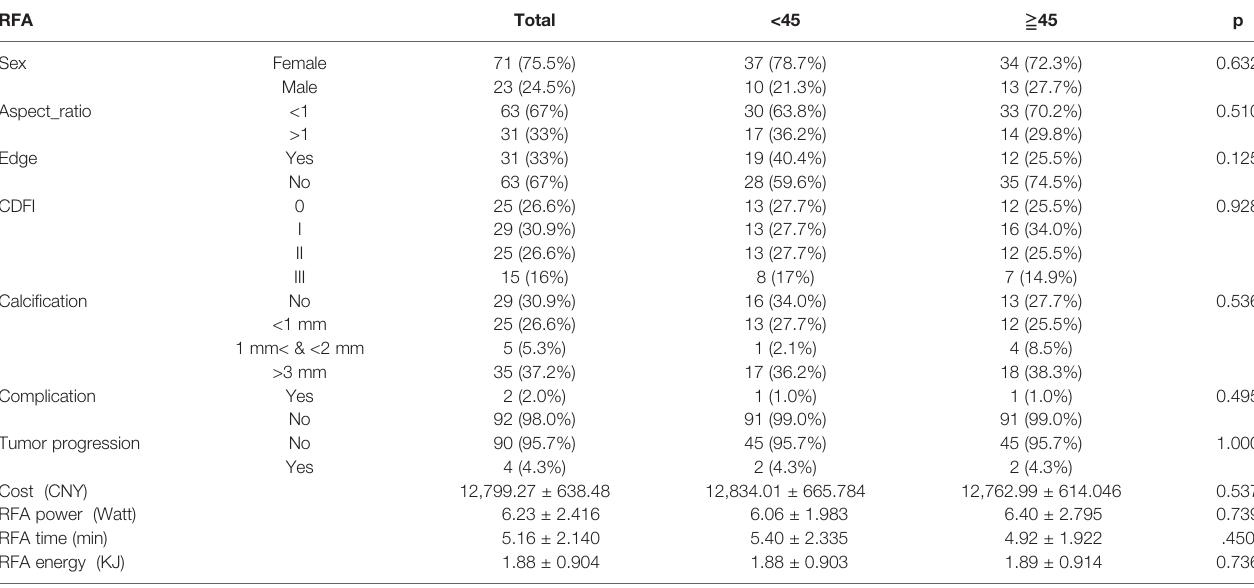
TABLE 2 | Characteristics and outcomes of RFA according to age subgroups.